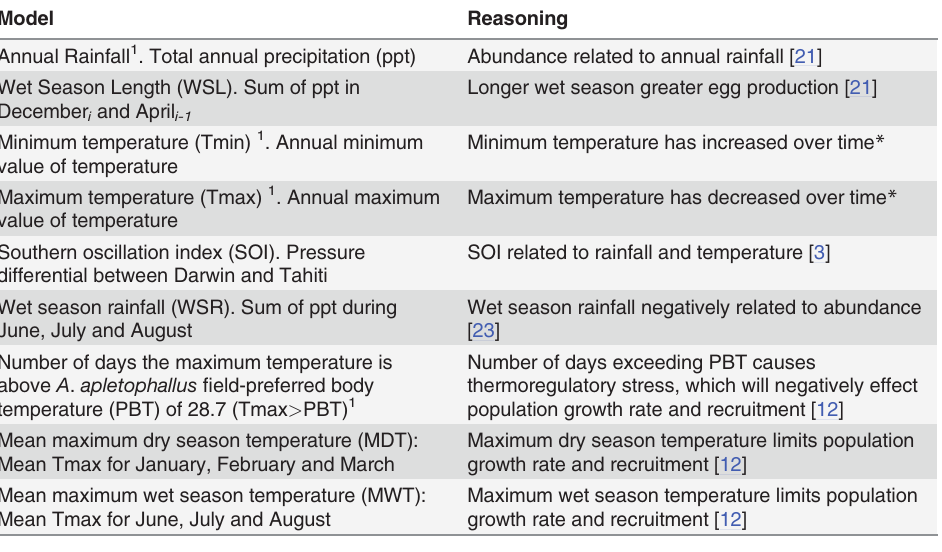
Table 1. Explanatory variables used in the model set and justi fi cation of their inclusion.